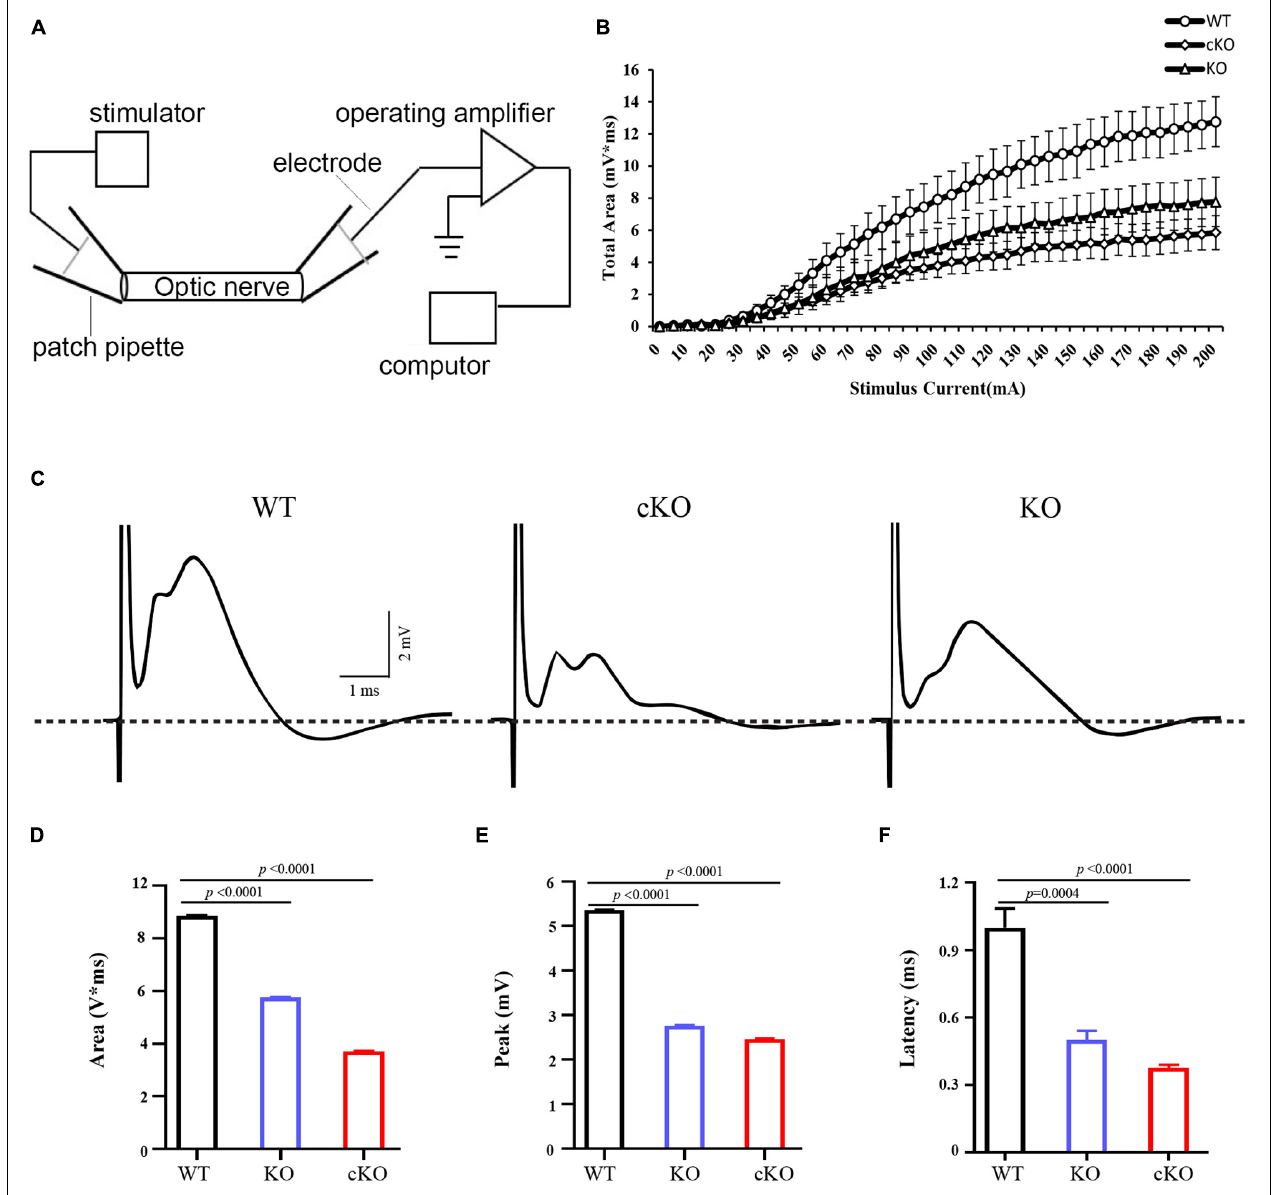
FIGURE 4 | Electrophysiological measurements of CAP from optic nerves. (A) The diagram of electrophysiological measurements of CAP from optic nerve. (B) Normalized total CAP area of optic nerves showing a S-type growth in response to increasing stimulus current ( n = 5, 7, 4). (C) Representative 70% maximum CAP of optic nerves from wild-type (WT), conditional knockout ( cKO ) and conventional mutants ( KO ) mice. The large stimulus artifact has been truncated and is followed by a polyphasic waveform peaks. And compared to the control groups, the first peak became smaller and the third peak became larger in the Itpr2 cKO and KO groups. (D) Analysis of the values for the CAP area (WT: 8.878 ± 0.01151 mV*ms, KO : 5.759 ± 0.03151 mV*ms, cKO : 3.713 ± 0.01563 mV*ms, one-way ANOVA, F = 14817, p < 0.0001, n = 6, 6, 6.) in the optic nerves. (E) Analysis of the values for CAP peak (WT: 5.364 ± 0.01007 mV, KO : 2.763 ± 0.01365 mV, cKO : 2.464 ± 0.01118 mV, one-way ANOVA, F = 18485, p < 0.0001, n = 6, 6, 6) in the optic nerves. (F) Analysis of the values for CAP latency (WT: 1.000 ± 0.08515 ms, KO : 0.5000 ± 0.04082 ms, cKO : 0.3750 ± 0.01443 ms, one-way ANOVA, F = 29.99, p < 0.0001, n = 5, 4, 4.) in the optic nerves. Error bars indicate Means ±